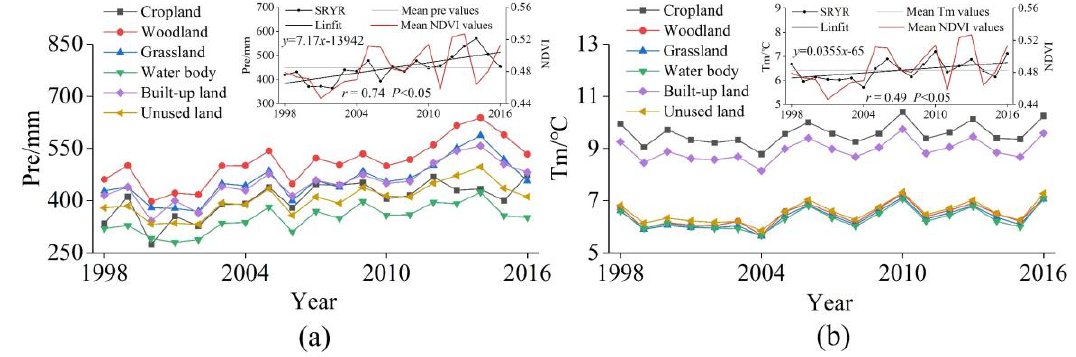
Figure 4. Temporal change in the climate elements from 1998 to 2016: ( a ) precipitation; ( b ) temperature.